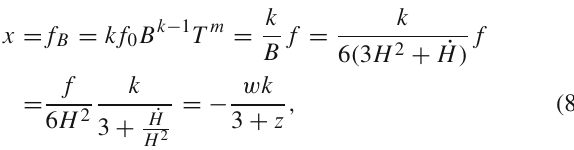
The arrows represent the direction of the velocity field and the trajec- tories reveal their stability properties as described for this (cid:2) (cid:3) m − 1 1 . m k − 1 3 + z